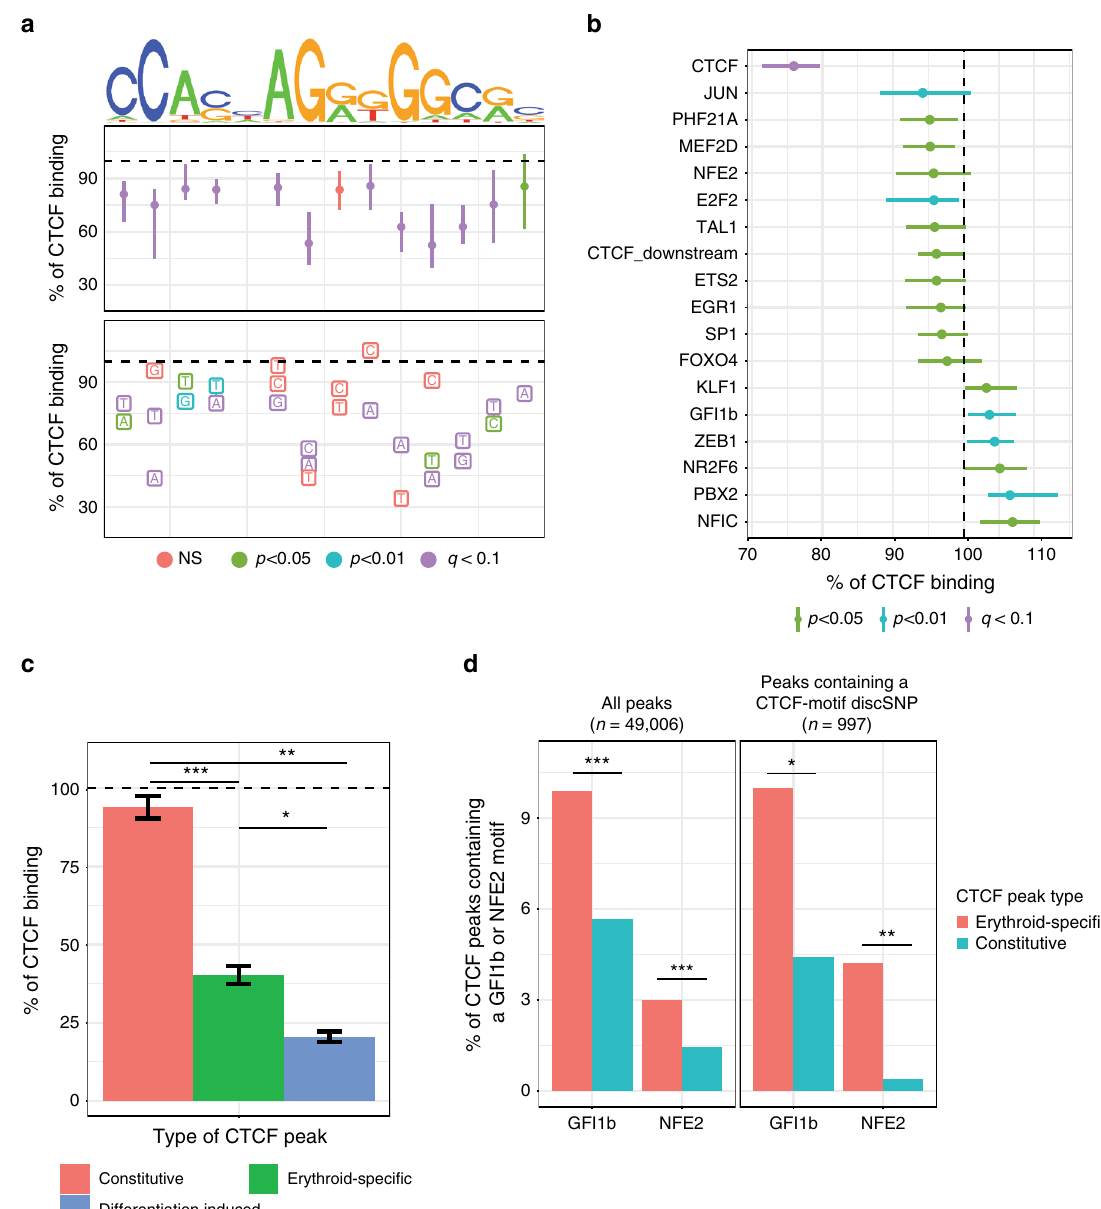
Fig. 5 Genetic variation between erythroid cell lines reveals genetic regulatory sequences directing CTCF chromatin occupancy. a Sequence logo re fl ecting existing CTCF factor motif information and the percent impact on CTCF binding intensity (median ± 95% CI) associated with mutations at various positions and to particular alternative nucleotides. b TFs whose motifs signi fi cantly alter CTCF binding (% impact, median ± 95% CI) when disrupted by a discSNP. Vertical line indicates no effect, and color indicates signi fi cance level. c The effect of discSNPs that disrupt CTCF motifs on CTCF binding at constitutive, erythroid-speci fi c, or erythroid differentiation-induced CTCF peaks. Percent impact, median ± 95% CI. * Wilcoxon's p = 1e − 6, ** p = 1.7e − 14, *** p = 4.7e − 39. d GFI1b and NFE2 motifs are enriched in erythroid-speci fi c CTCF peaks (foreground) relative to constitutive CTCF peaks (background) both when considering all CTCF peaks and the subset that contain a CTCF motif discSNP as in Fig. 5c. Benjamini – Hochberg q -values: * q = 0.02, ** q = 0.001, *** q =